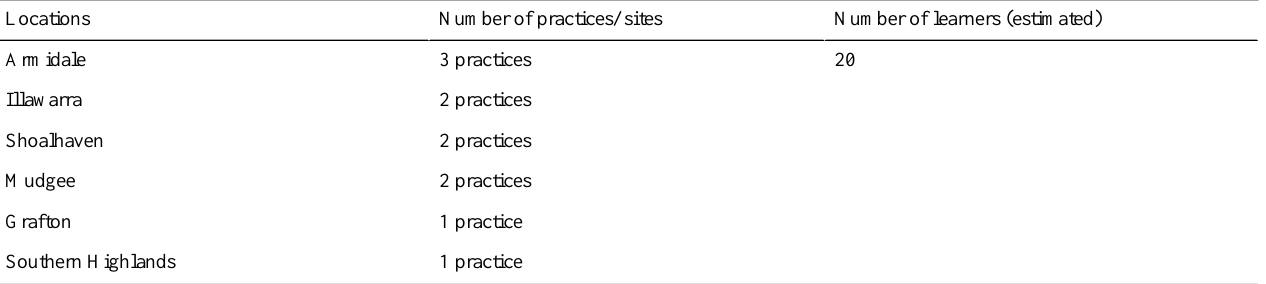
Table 2. Proposed number of sites and learners for the telehealth real patient learning participation in GP practice (these learners are also included in Table 1 for virtual